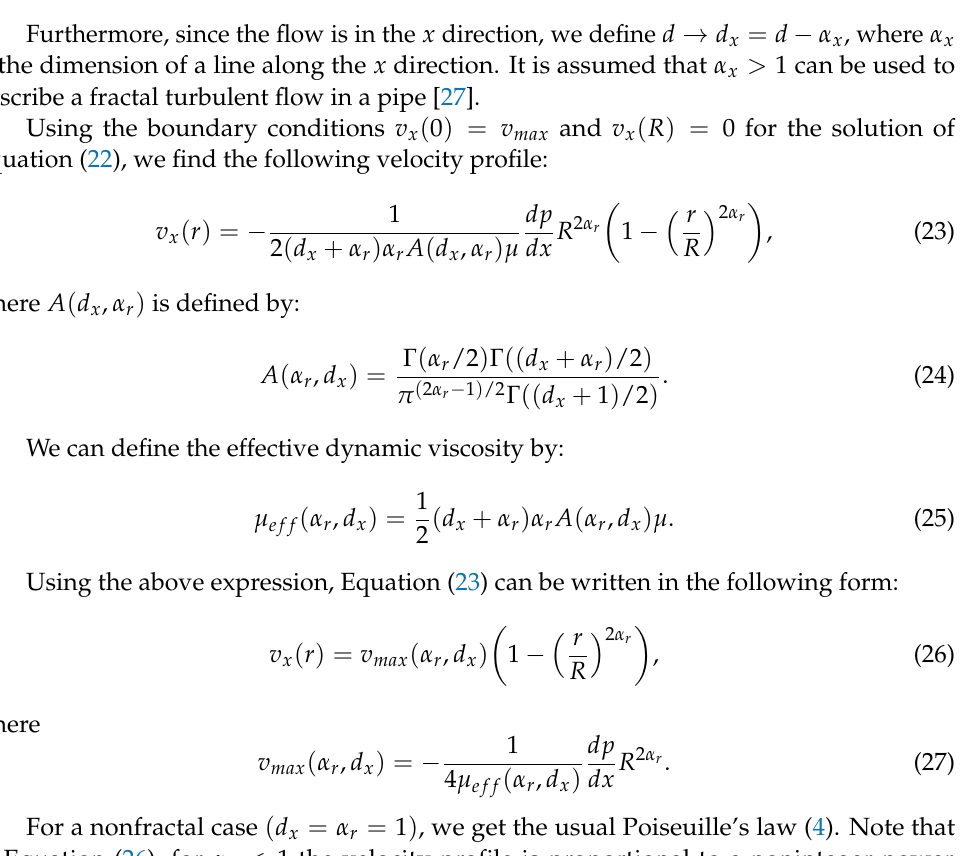
Figure 5. Schematic of self-similar fluid flow through a tube with a rough